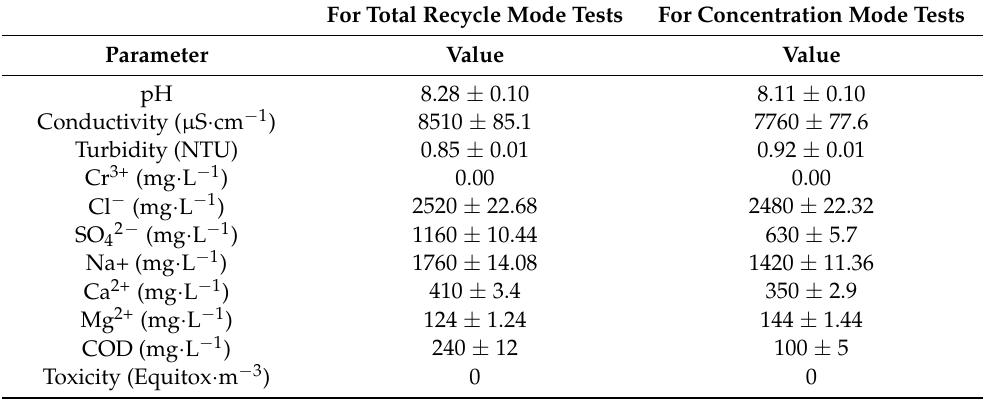
Table 1. SBR effluent characterisation